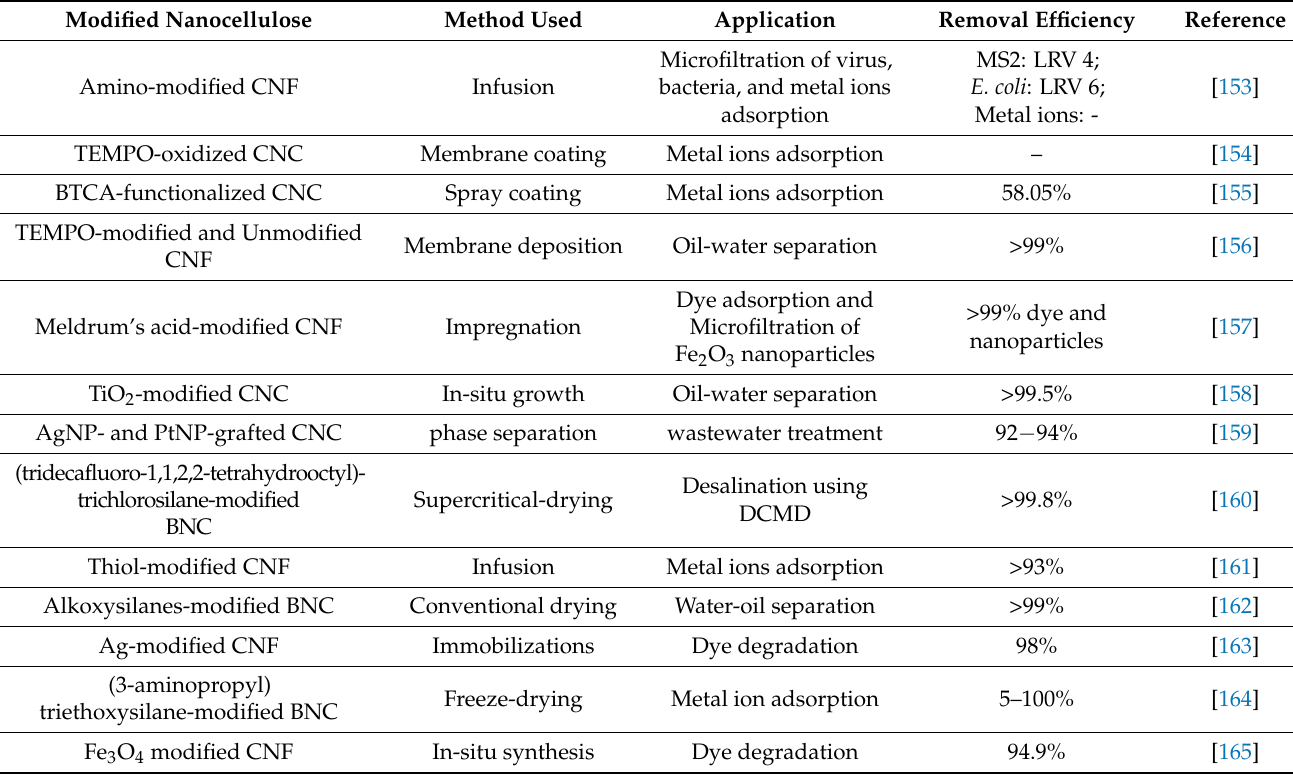
Table 7. Application of modified nanocellulose membranes in the removal of contaminants for water treatment.